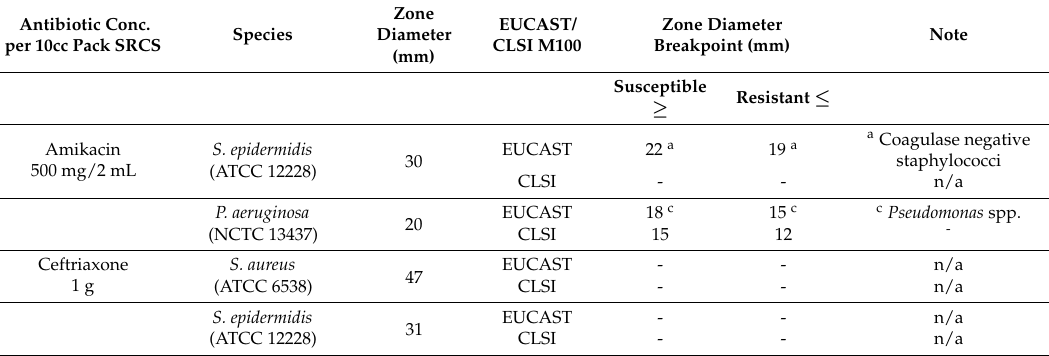
Table 4. Zones of Inhibition (ZOI) data with EUCAST clinical breakpoint tables v 6.0 and CLSI M100